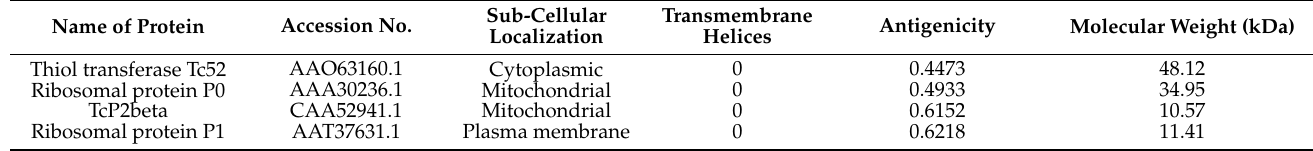
Table 1. T. cruzi vaccine candidate proteins are described in detail.